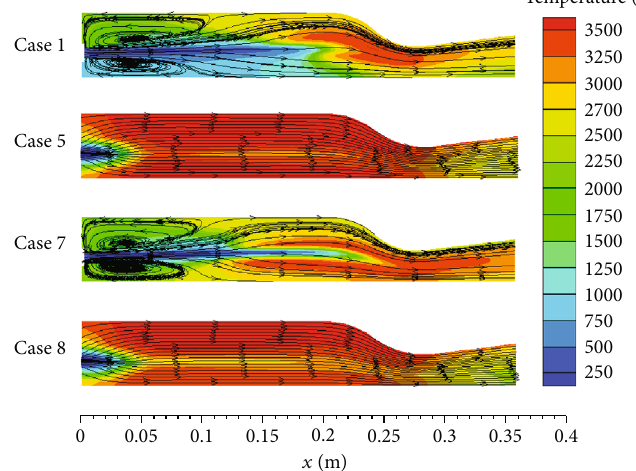
Figure 8: The numerical result of temperature distribution and